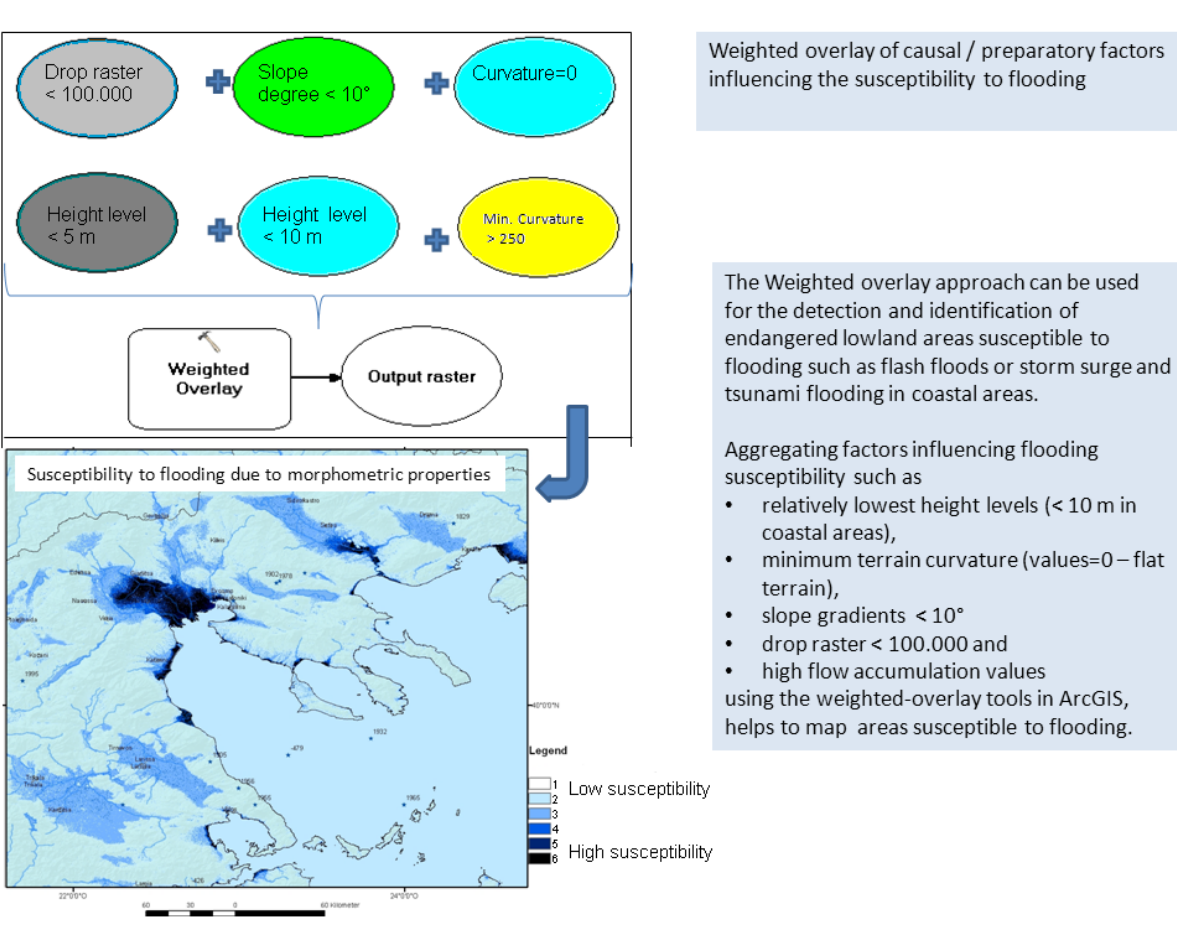
Figure 4. Weighted overlay in ArcGIS/ArcMap of morphometric factors influencing the susceptibility to